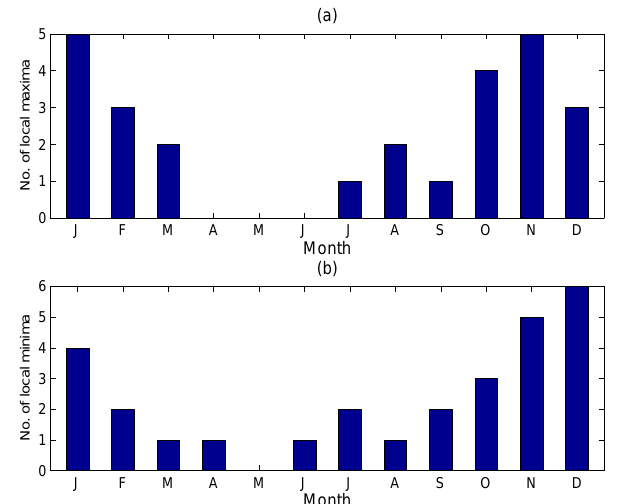
Fig. 3. Histogram of temporal location of (a) warm and (b) cold events for the Ni˜no–3.4 index. The event thresholds are shown by the dashed horizontal lines in Fig. 1. Notice the preferential occur- rence of both warm and cold events during the boreal